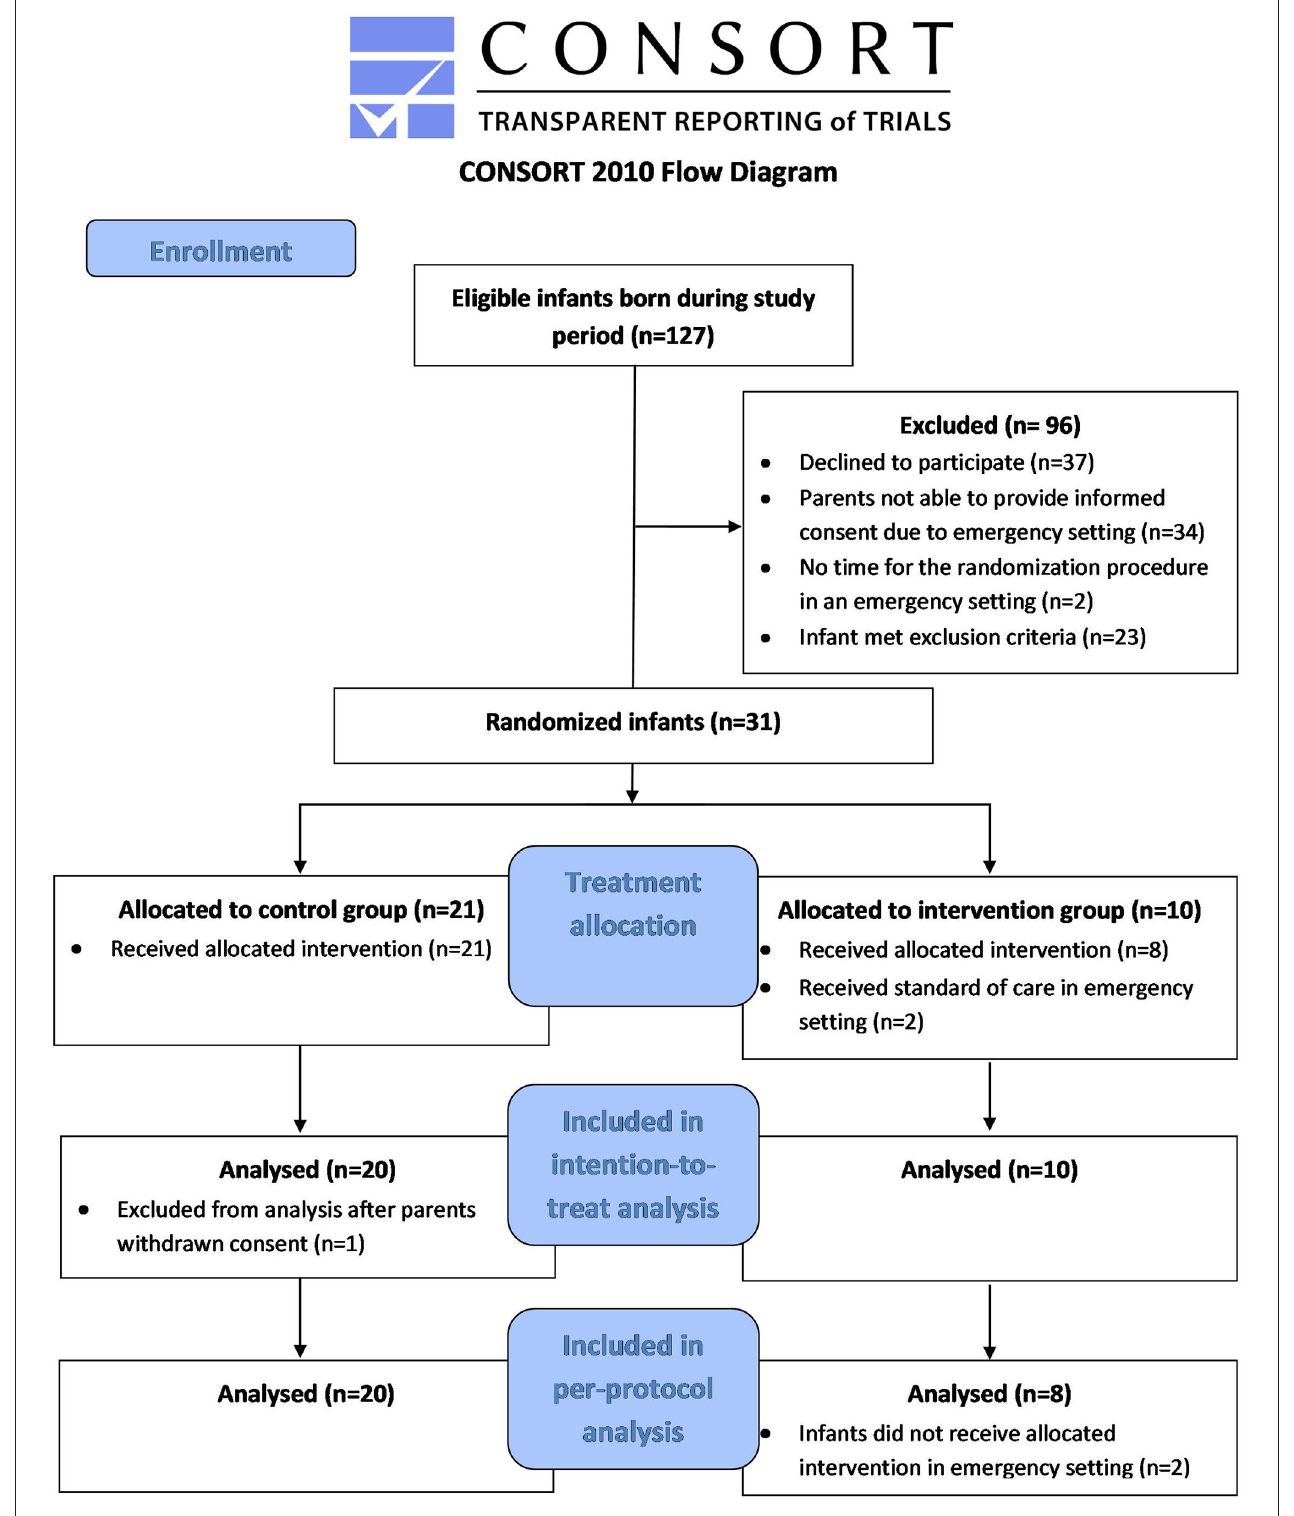
FIGURE 2 | Consort 2010